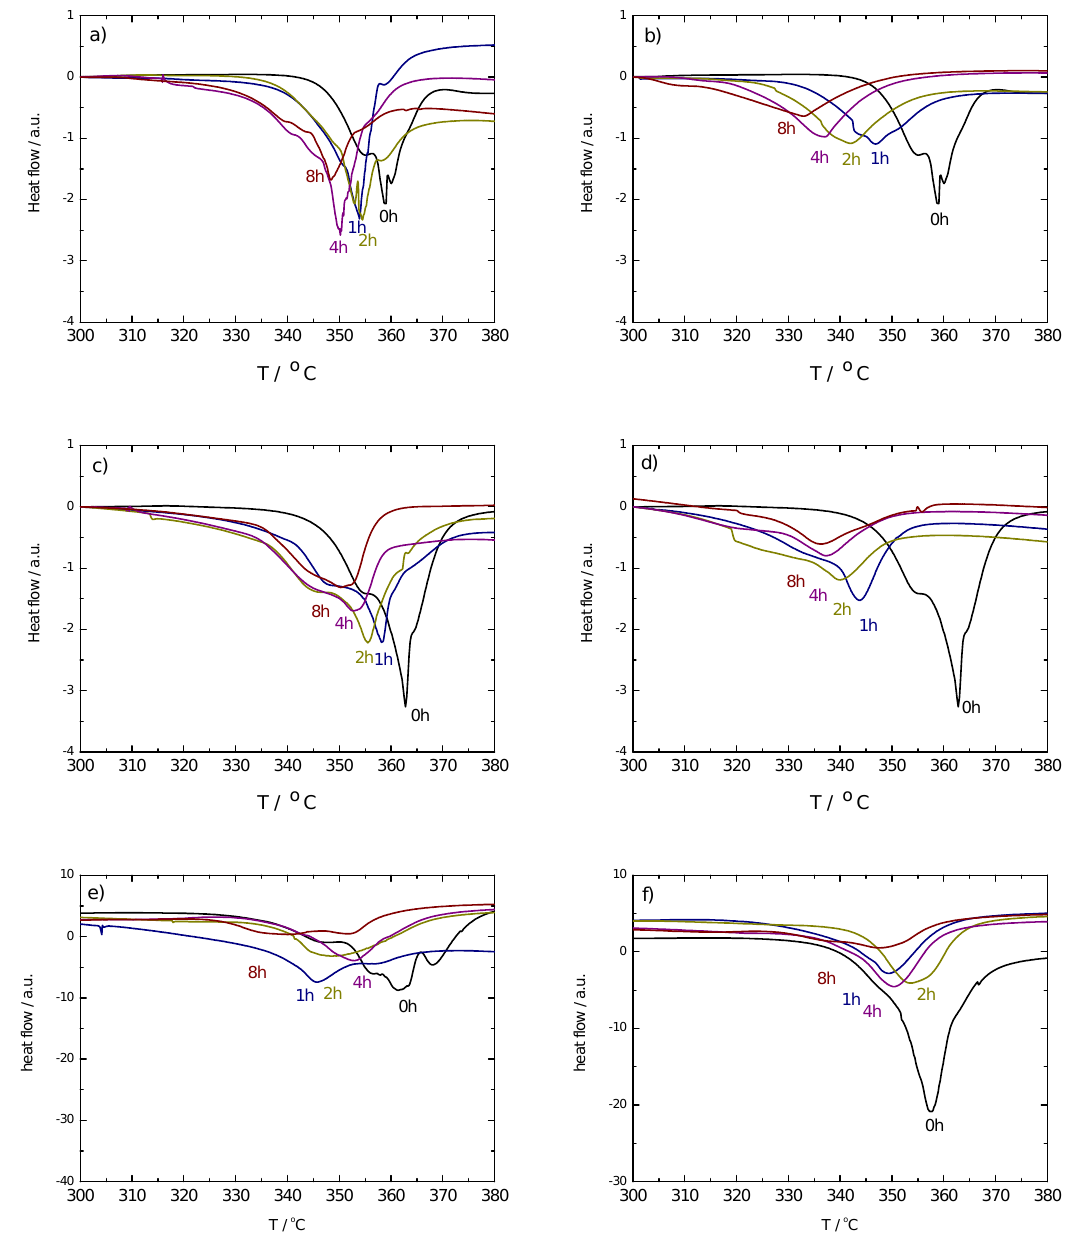
Figure 5. Corresponding DSC curves of ball milled α βγ (top, ( a , b )) and γ (middle, ( c , d )), with 1.6 mol% (left-hand side, ( a , c )) and 10 mol% (rigth-hand side, ( b , d )) of TiF 3 , respectively. Bottom: Corresponding DSC curves of the ball milled β 64 (left-hand side, ( e )) and β 92 (right-hand side, ( f )) with 10 mol% of TiF 3 . Only the main decomposition region between 330 and 380 ◦ C is shown. Measurements were done under dynamic conditions in protective Ar flow, with 2 ◦ C/min heating rates. The curves have been shifted to show the peak